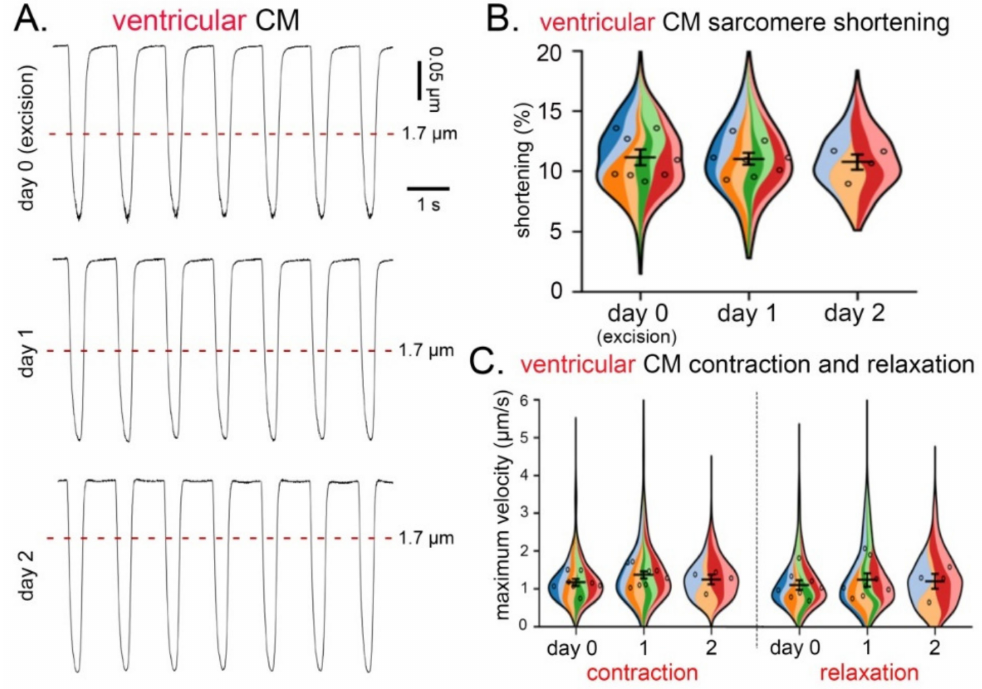
Figure 4. Contraction and relaxation of ventricular CM over three consecutive days of cell isolation from live cardiac tissue slices of the same heart. ( A ) Recordings of sarcomere shortening (in response to field stimulation at 0.5 Hz) over three consecutive days of CM isolation. ( B ) Degree of sarcomere shortening (%) in ventricular CM over three consecutive days. ( C ) Maximum velocity of contraction and relaxation in ventricular CM over three consecutive days of CM isolation; n = 4–8 hearts, 150–300 CM/day of isolation. ( B , C ), each color represents data from one heart. Within each colored area, the open circles represent the average of all cells recorded from the same